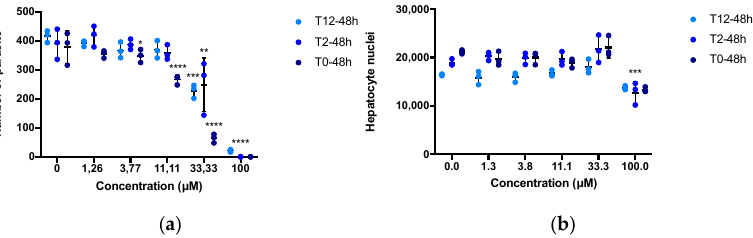
Figure 4. MB shows weak inhibition of liver stage infection in vitro. ( a ) MB activity against P. berghei liver stages was investigated at concentrations ranging from 1.25 to 100 µM. MB was added simultaneously to the hepatocyte invasion (0 h), 2 h or 12 h pi. Activity is presented as the number of schizonts counted (blue bars = EEFs). ( b ) Toxicity to host cells is presented as the number of hepatocyte nuclei. Data are presented from one representative experiment. The black lines represent the mean and standard deviation. * p < 0.05; ** p < 0.01; *** p < 0.001; **** p = 0.0001 when compared to control by t -test.